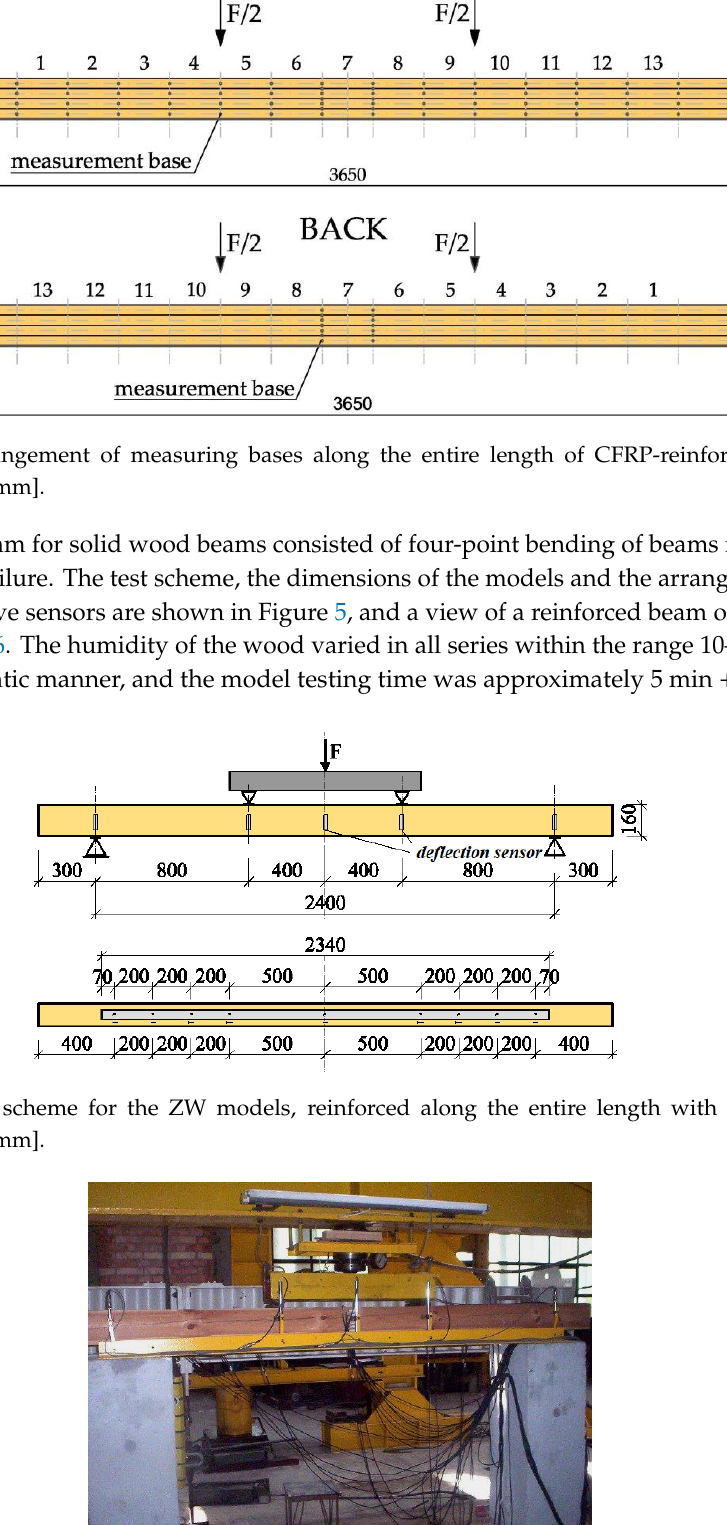
Figure 6. View of a ZW model, reinforced along its entire length with CFRP tape, during the test.